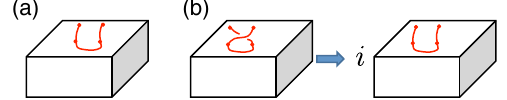
FIG. 8. Beginning with the configuration shown in (a), we exchange two open string ends at the surface. Returning the strings to their original configuration (b) multiplies the eigenstate of the Walker-Wang model by (cid:4) i , demonstrating that these defects have semionic